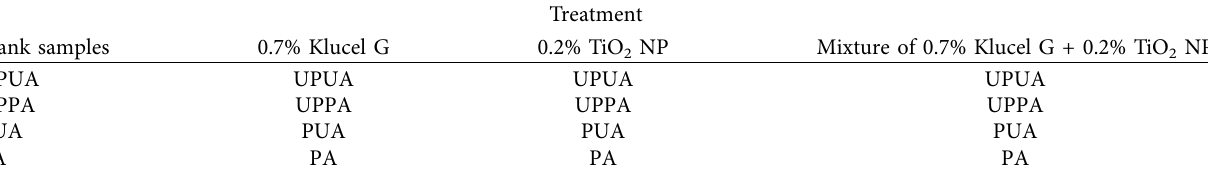
Table 1: Treatments used for the four paper samples.